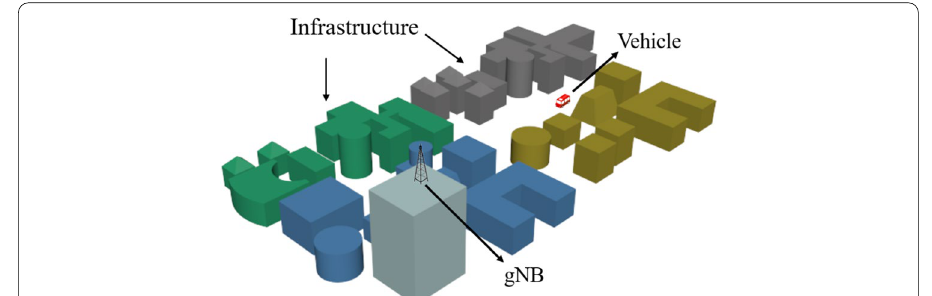
Fig. 20 The three-dimensional view of simulating gNB of single sector coverage in urban